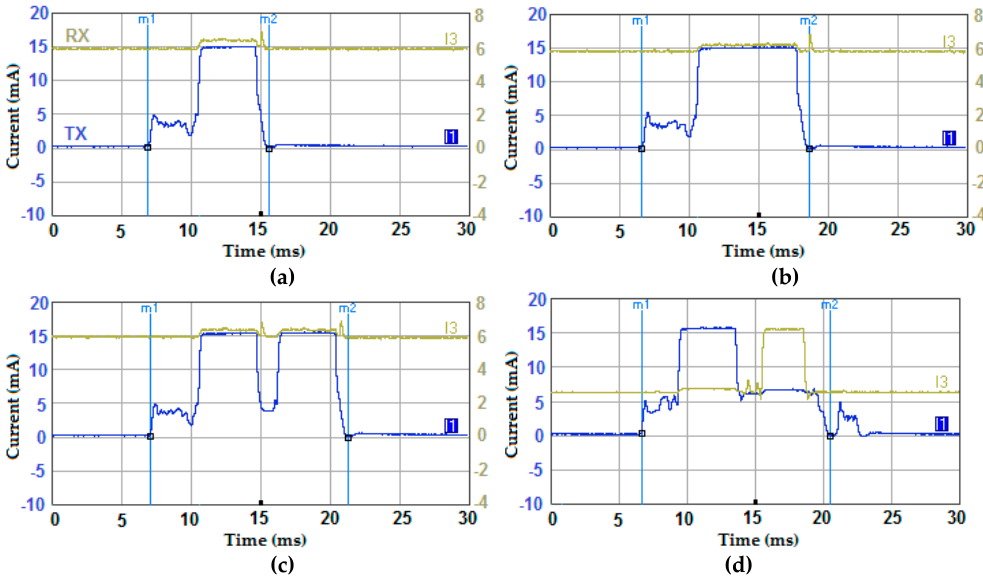
Figure 14. Current consumption profile of the transmitter and the receiver when using different data transfer schemes; ( a ) simple transmissions, ( b ) FEC, ( c ) two BR, and ( d ) a SAW-ARQ protocol (also referred to as 1-Rep-ACK in this work).